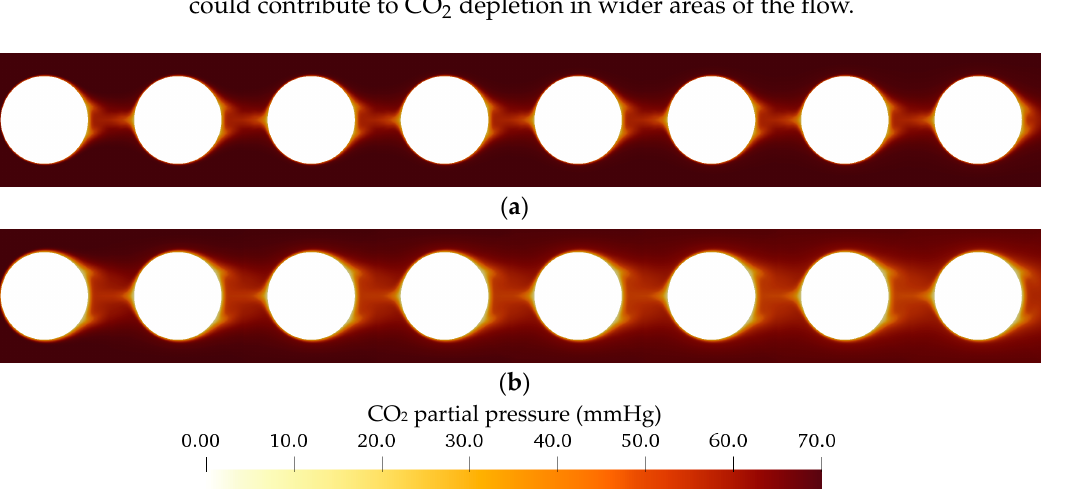
Figure 13. Distribution of CO 2 partial pressure within the simplified packing ( a ) porcine blood ( b ) water.